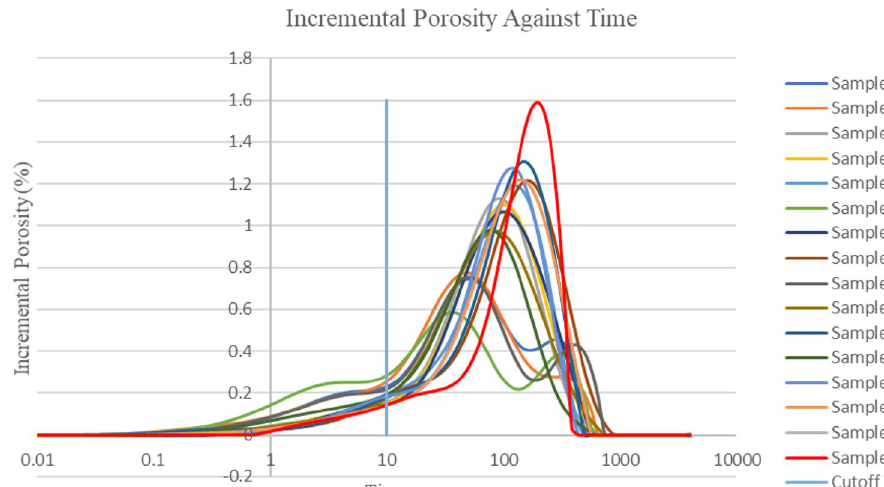
Fig. 3 Incremental porosity of the pore sample with time